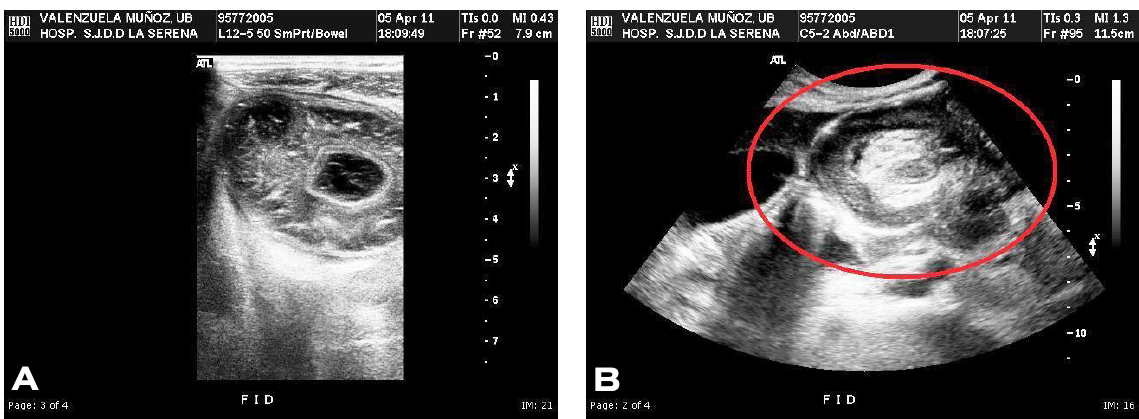
Figure 1. A Abdominal ultrasound focusing over the right lower abdominal quadrant, where the classic “target sign”, also known as the “doughnut sign”, was revealed. These signs are pathognomonic of intussusception. B Longitudinal view showing the “pseudo-kidney sign”, another pathognomonic intussusception sign.